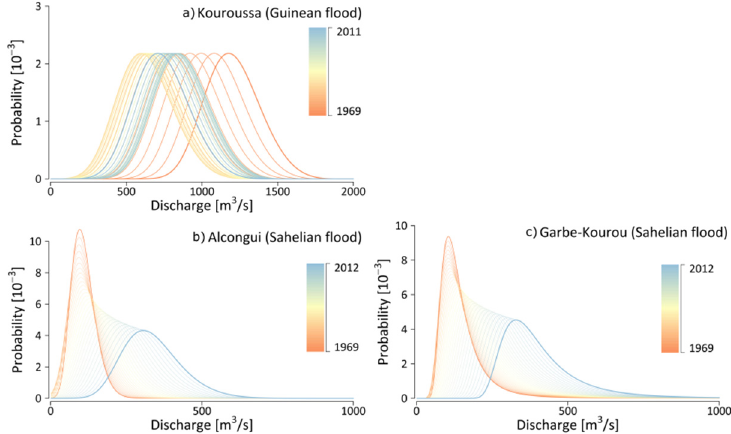
Figure 6. Non-stationary extreme value probability distributions for ( a ) Kouroussa; ( b ) Alcongui and ( c ) Garbe-Kourou.